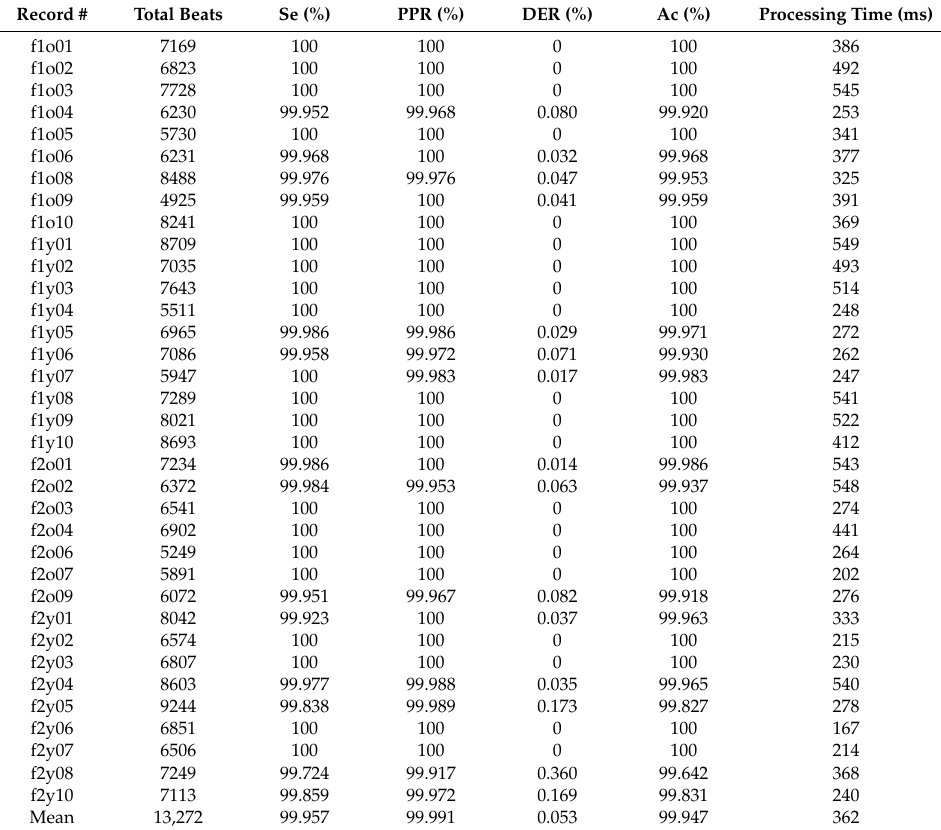
Table 4. Performance evaluation of the proposed method using the Fantasia